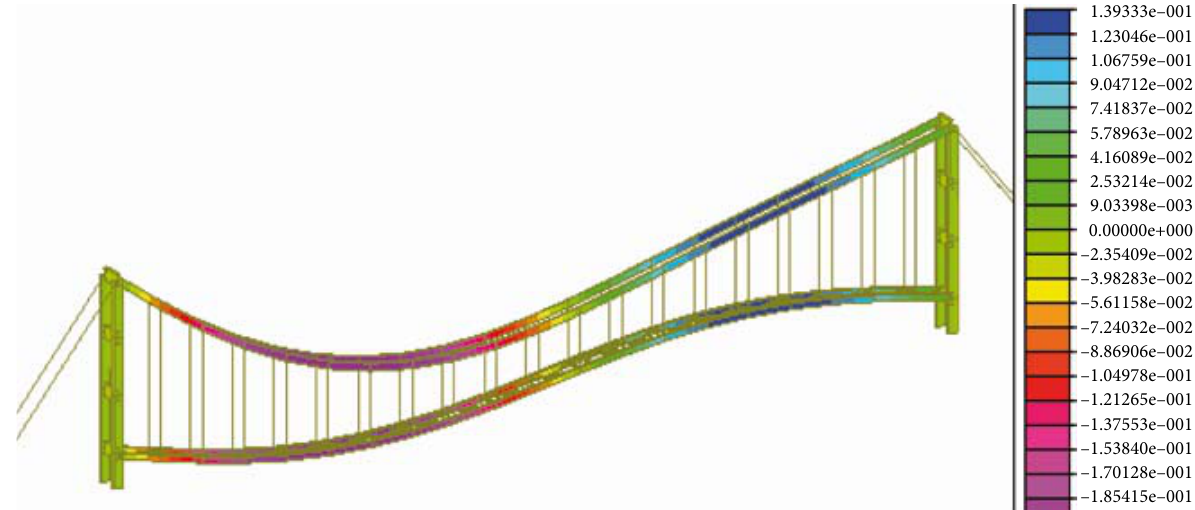
Fig. 11 . Deformed FEM of the bridge under unsymmetrical loading (ξ = 0.6, γ =